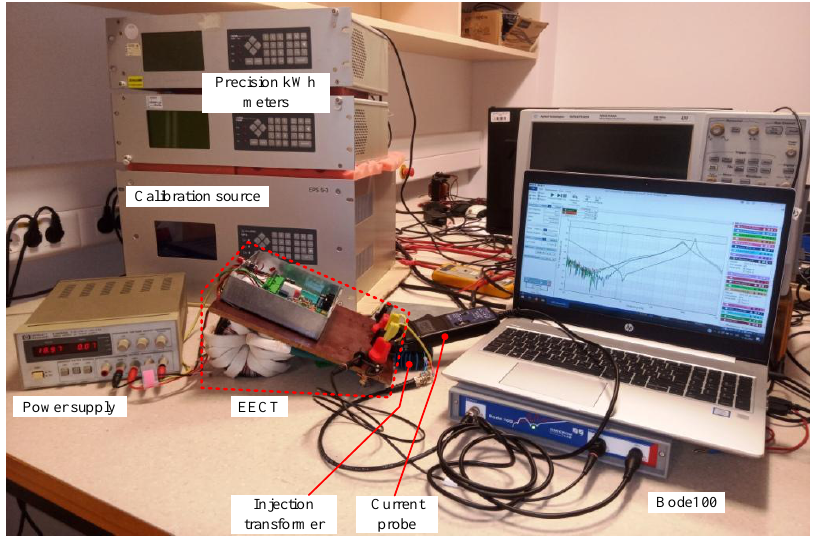
Sensors 2022 , 22 , x FOR PEER REVIEW 13 of 17